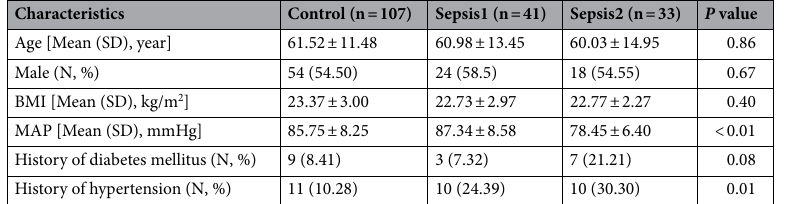
Raw diaphragmatic parameter a